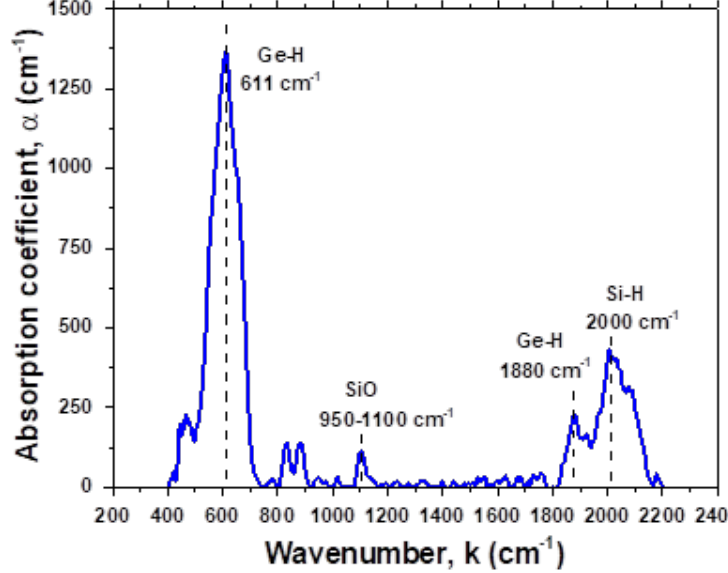
Figure 6. General view of IR spectra in the Si–Ge:H samples deposited at R H = 0.9.